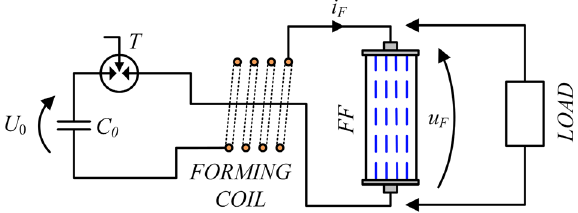
Figure 2. Schematic diagram of the fuse-based high-power pulse forming system supplied by pulse capacitor bank: